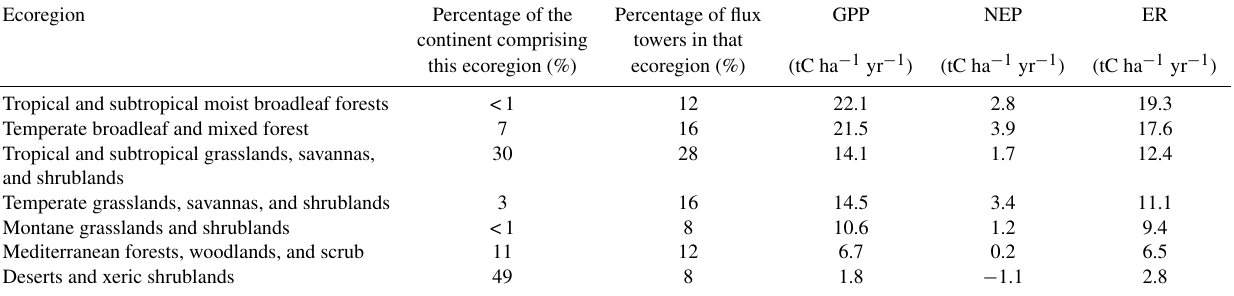
Table 2. Summary of the representation of Australian OzFlux tower sites within each ecoregion compared with the total percentage of the continent comprising this ecoregion (Department of Environment, 2012). The mean carbon fluxes are given for each ecoregion type. Ecoregion Percentage of the Percentage of flux GPP NEP ER continent comprising towers in that this ecoregion (%) ecoregion (%) (tC ha − 1 yr − 1 ) (tC ha − 1 yr − 1 )